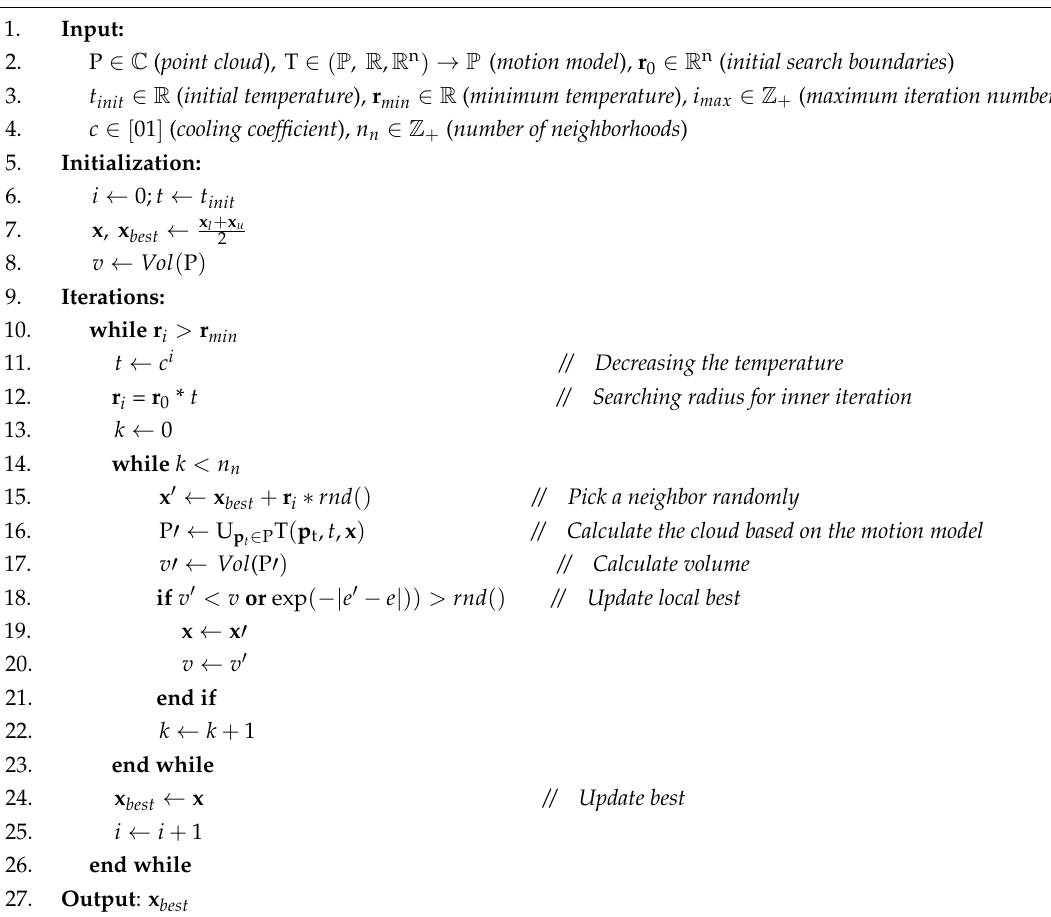
Algorithm A1 Simulated annealing algorithm for volume